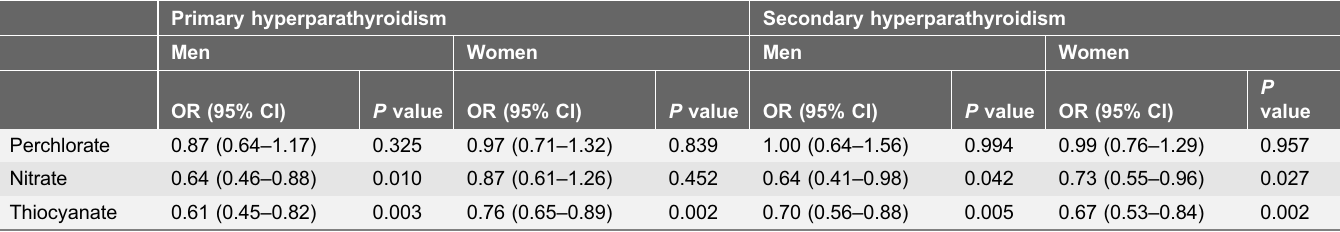
Table 6. Adjusted odds ratios (ORs) with 95% confidence intervals (95% CIs) for primary hyperparathyroidism (defined as parathyroid hormone . 70 pg/mL and corrected calcium $ 9.5 mg/dL) and secondary hyperparathyroidism (defined as parathyroid hormone . 70 pg/mL and corrected calcium , 9.5 mg/dL) by creatinine-corrected urinary concentrations of perchlorate, nitrate, and thiocyanate among the United States adults, NHANES 2005–2006.